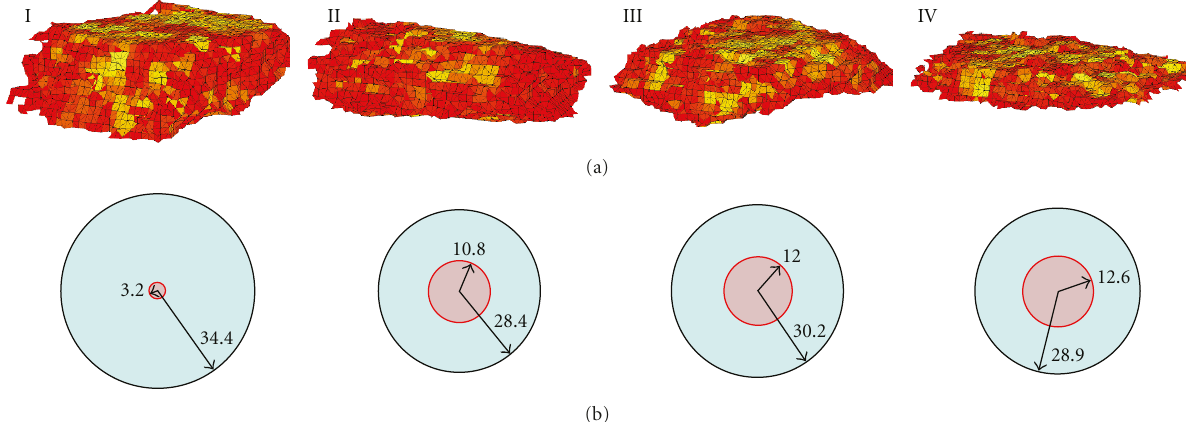
Figure 9: (a) The evaluated volume of landmarks I to IV. Note that the volumes are scaled to match the image domain. (b) The radii of convergence of the landmarks. The red circle and the corresponding vector are the minimum area, where the method converges to the right result. The maximum distance is displayed by the blue circle with its maximum vector. Table 1: Overview of the evaluation results of the manually and randomly selected landmarks. Manually Randomly